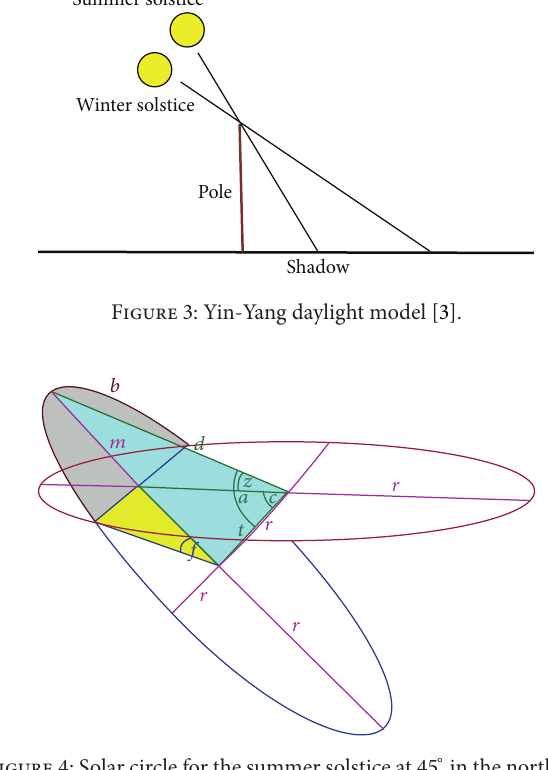
Figure 4: Solar circle for the summer solstice at 45 ∘ in the northern hemisphere (H. Glarner